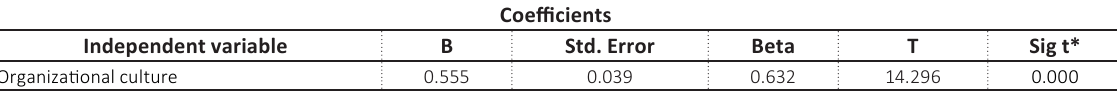
Table 8. Regression coefficients for